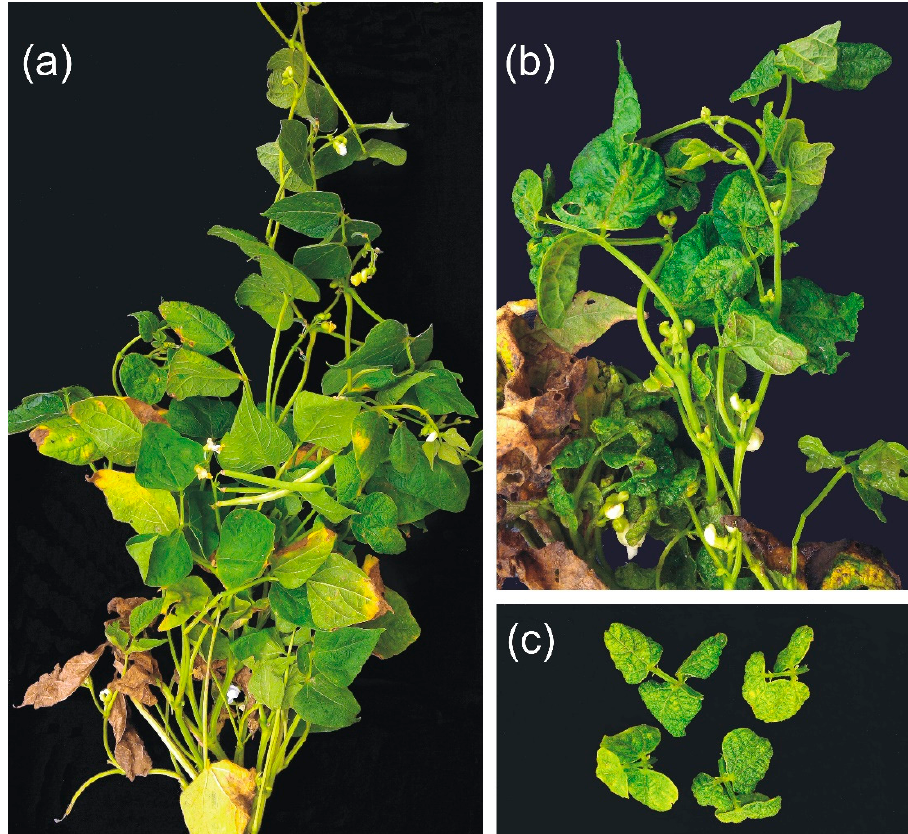
Figure 1. Symptoms in common bean plants collected in a commercial field in Luziânia, Goiás state with mixed infection by bean-associated cytorhabdovirus (BaCV), cowpea mild mottle virus (CPMMV), and bean golden mosaic virus (BGMV) and whitefly colonization. ( a ) Mosaic and leaf wrinkling. ( b ) Mosaic, severe leaf distortion, and deformation. ( c ) Detail of leaves with reduced area, yellow mosaic, and severe crinkling and curling.